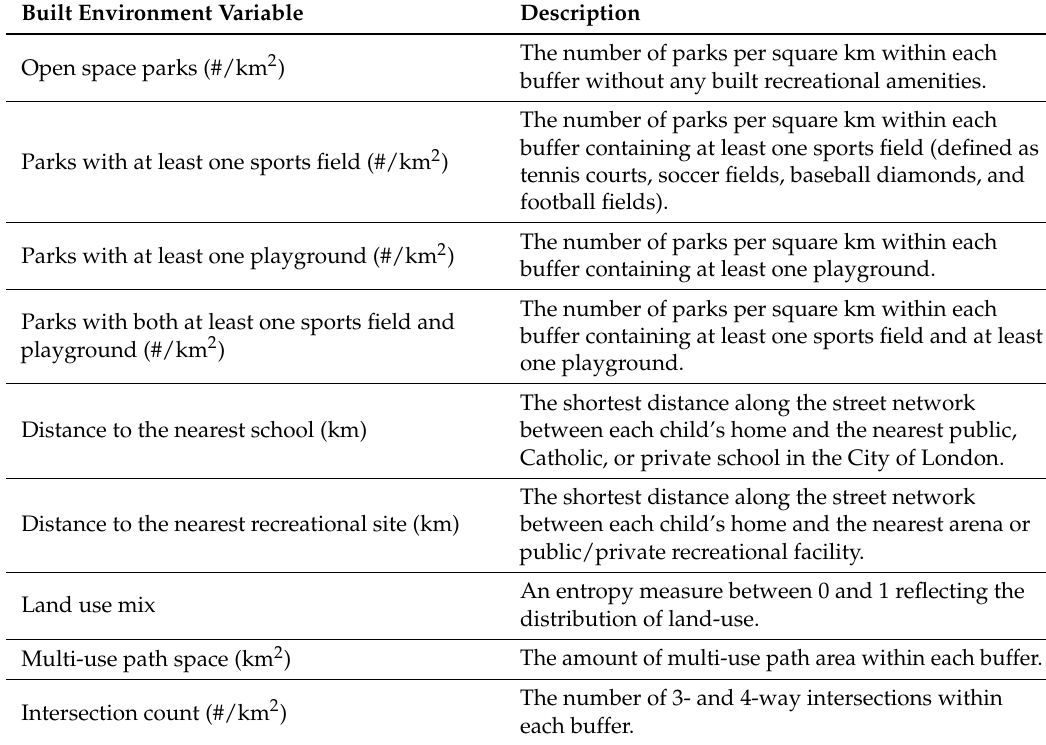
Table 1. Description of the built environment variables included in this